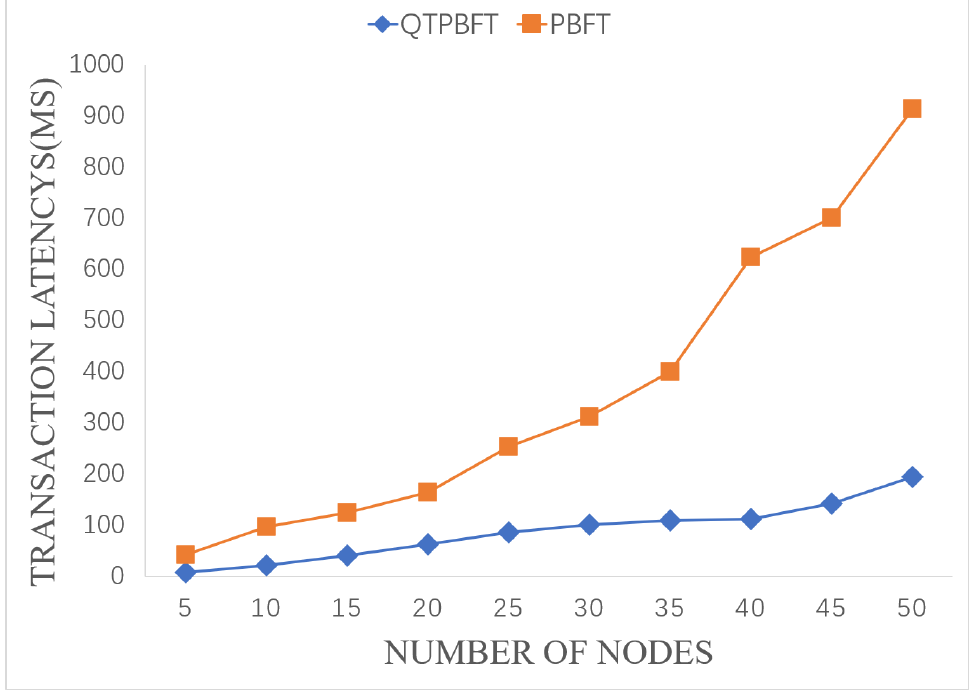
Figure 7. Comparison of the transaction latency of the two